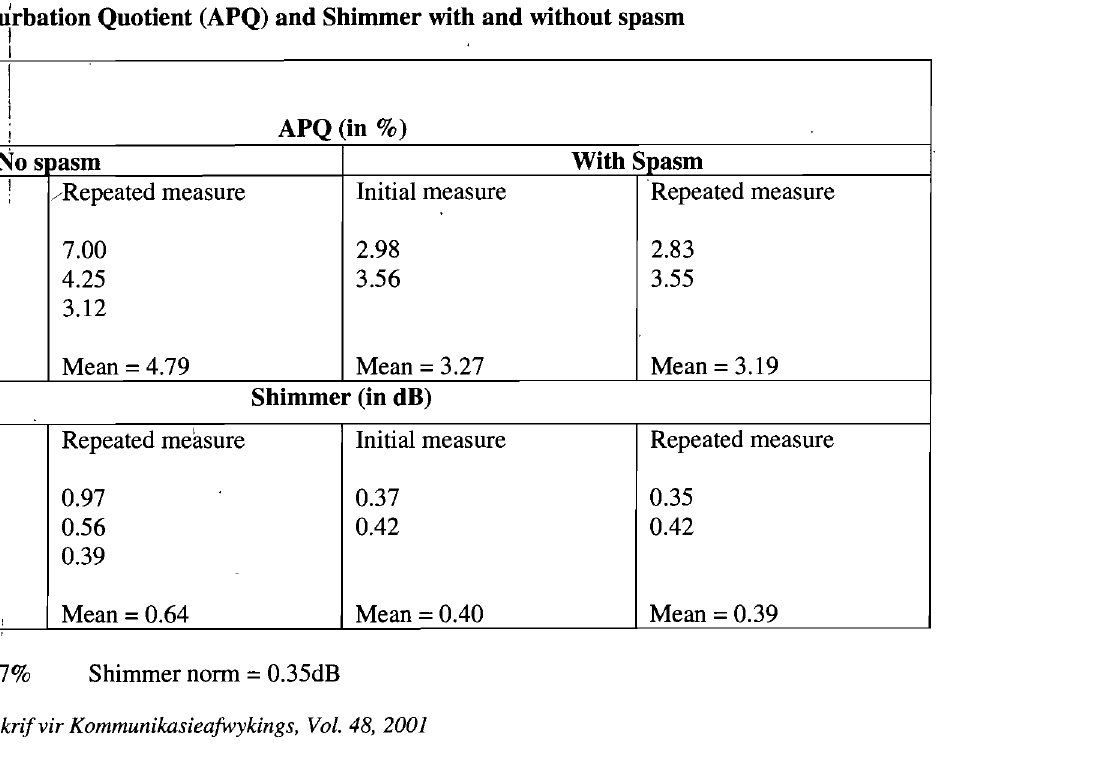
Table 4: Amplitude Perturbation Quotient (APQ) and Shimmer with and without spasm I . 1